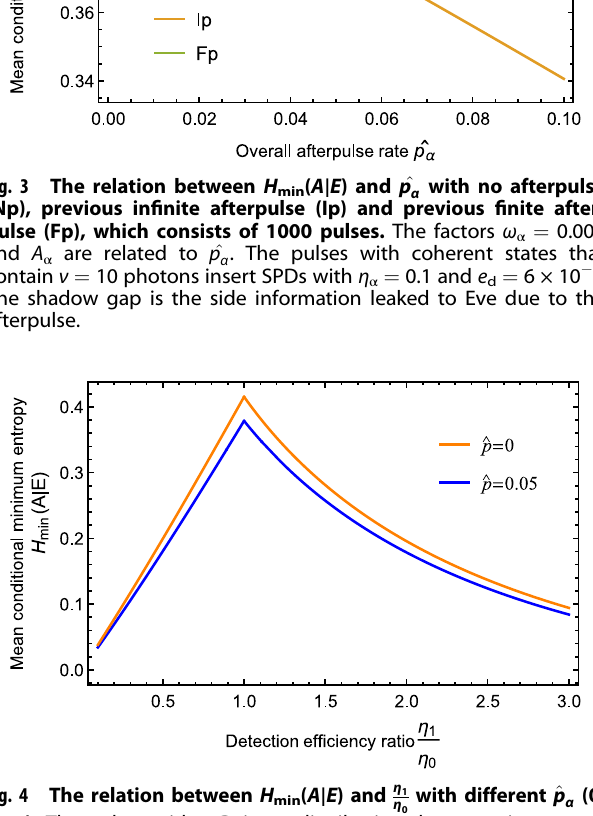
with different ^ p α (0, 0